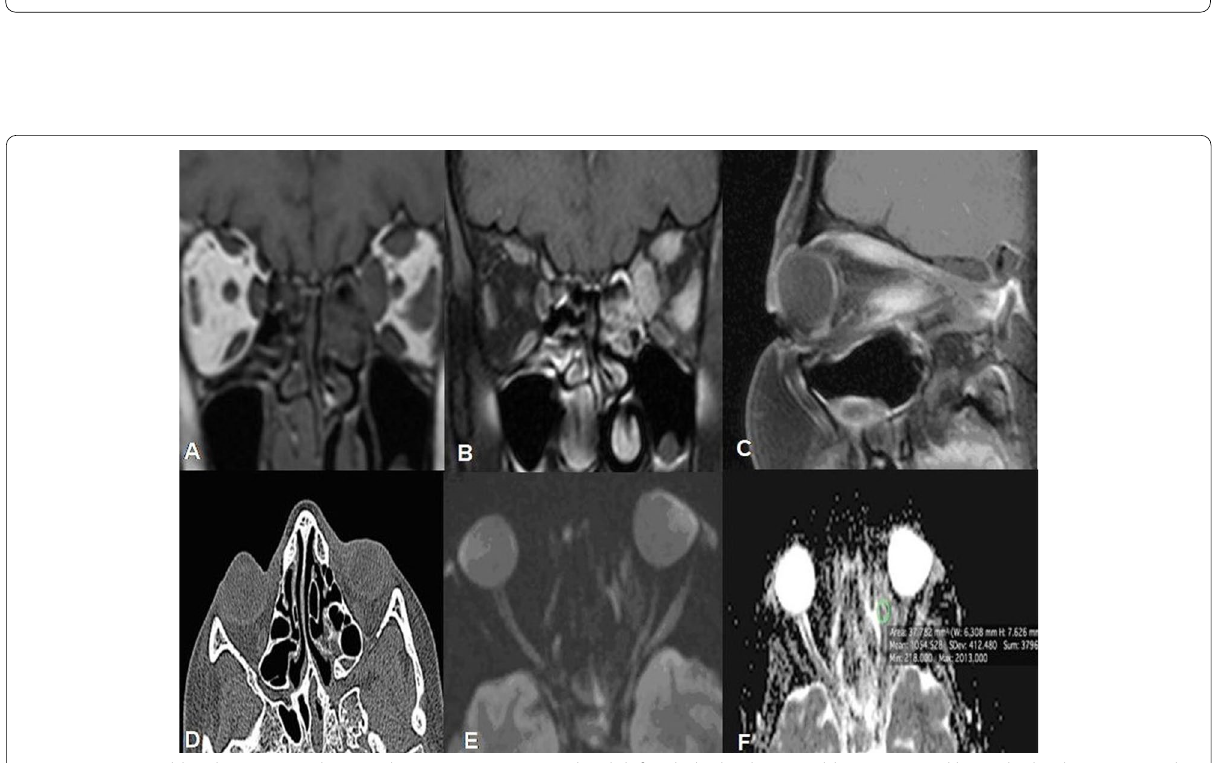
Fig. 5 A 23-year-old male patient with acute rhino-sinusitis presented with left-sided orbital pain, mild proptosis and limited orbital gaze. Coronal T1 A shows diffusely enlarged left superior, medial and lateral recti with mild stranding of the left retrobulbar fat. Coronal and sagittal T1 fat-sat post-contrast images B , C show homogeneous enhancement of these left orbital muscles. Axial non-contrast CT image bone window D reveals ethmoidal and sphenoidal mild sinusitis. No diffusion-weighted restriction seen on DWI (b 500 ) E and ADC F . The ADC value is 1.05 Left-sided orbital inflammatory pseudotumor, Myositic type; responded well 2 weeks after therapeutic trial with